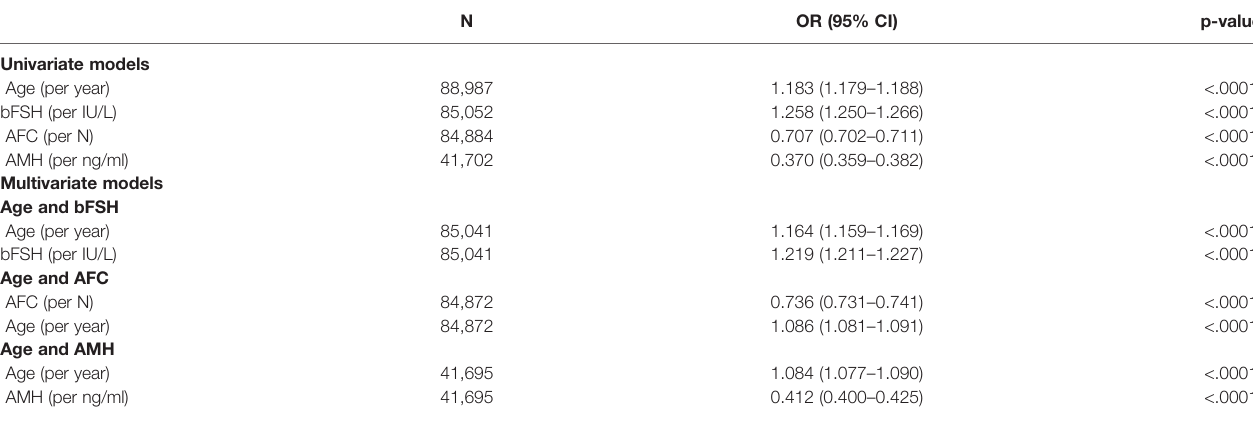
TABLE 2 | Univariate and multivariate models of age and ORT in the prediction of